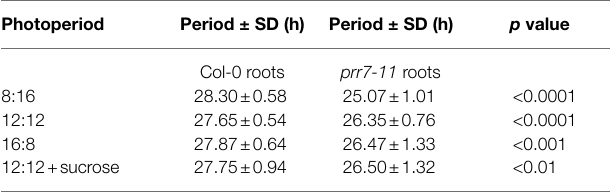
TABLE 1 | prr7-11 roots have a shorter period than Col-0